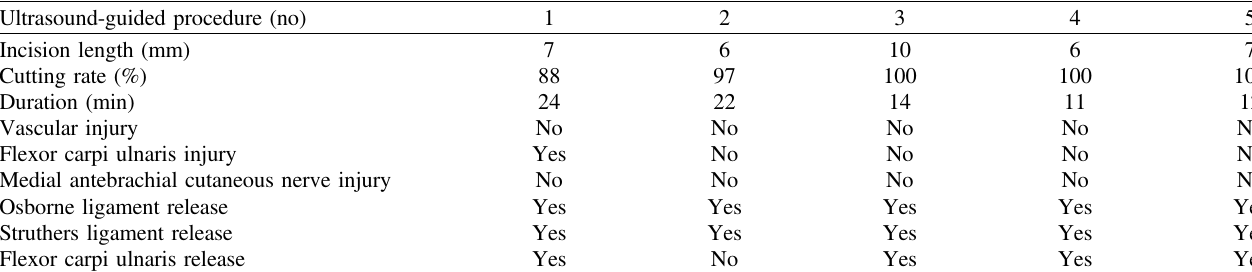
Table 1. Ultrasound-guided procedure outcomes. Ultrasound-guided procedure (no)